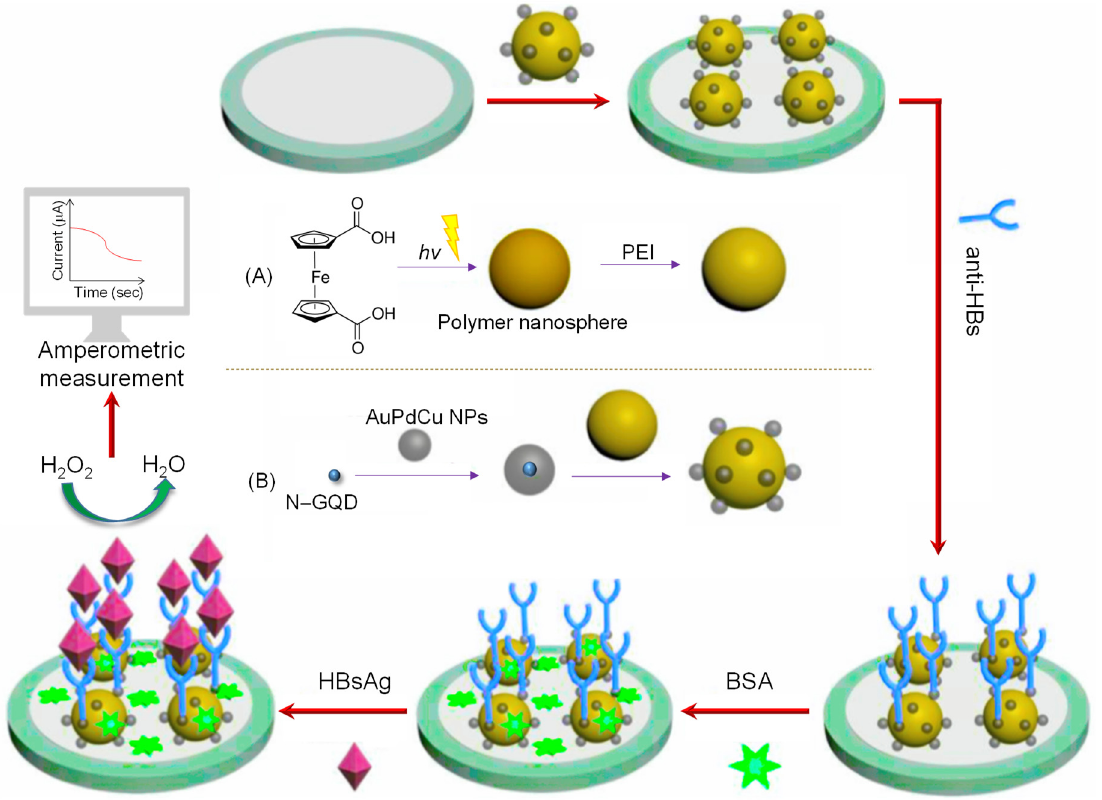
Figure 24. A picturized illustration of a label-free amperometric antibody-sensor for HBV virus and synthesis of: ( A ) polyethylenimine (PEI)-modified polymer nanospheres (PS); ( B ) N-GQDs / AuPdCu @ PS. Adapted from Mansuriya and Altintas [79].